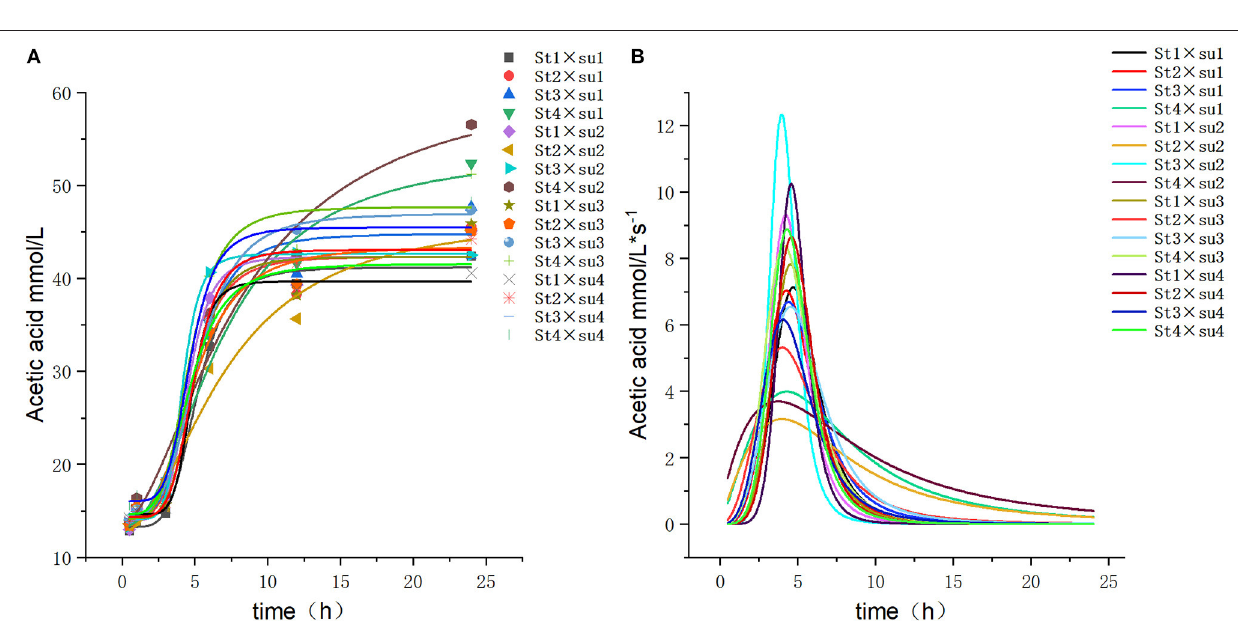
FIGURE 4 | Fitting model curve of acetic acid production. (A) Logistic model fitting curve. (B) Derivative of